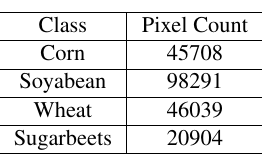
Table 2: Pixel Count of major classes